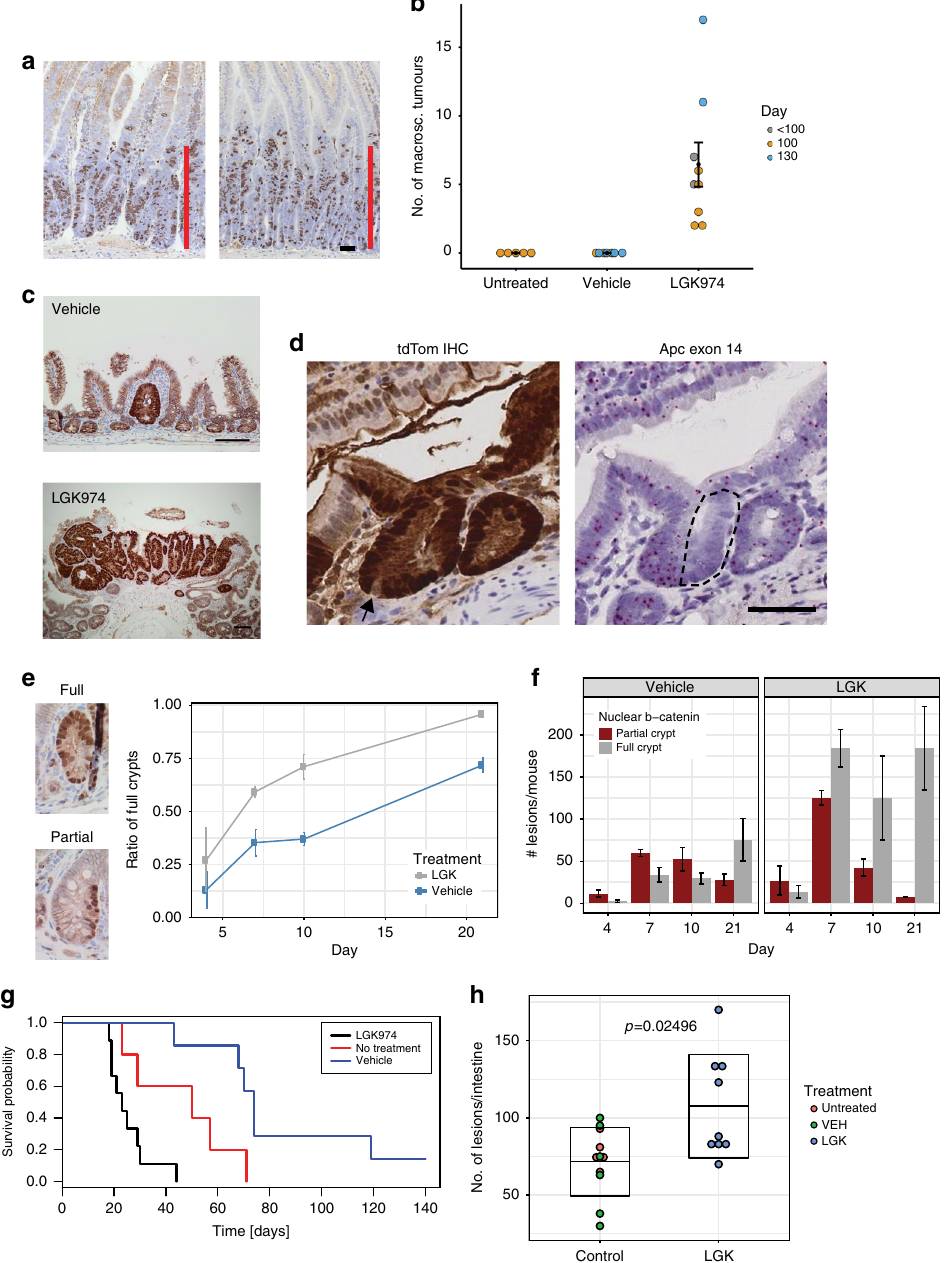
Fig. 4 Reduced Wnt ligand secretion does not affect Apc -de fi cient cell growth but accelerates tumorigenesis. a VilCre ER Apc fl / fl mice were induced and treated with LGK974 starting the following day. Mice were sampled at day 4 post induction, and proliferation assessed by BrdU staining. Scale bar = 50 µ m. b Lgr5Cre ER Apc fl / fl mice induced with 0.15 mg tamoxifen and treated with LGK974/vehicle 1 day p.i. The number of macroscopic adenomas was